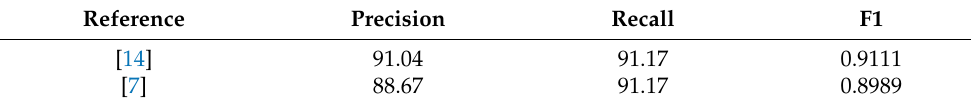
Table 7. Comparison of cited works using the MSL